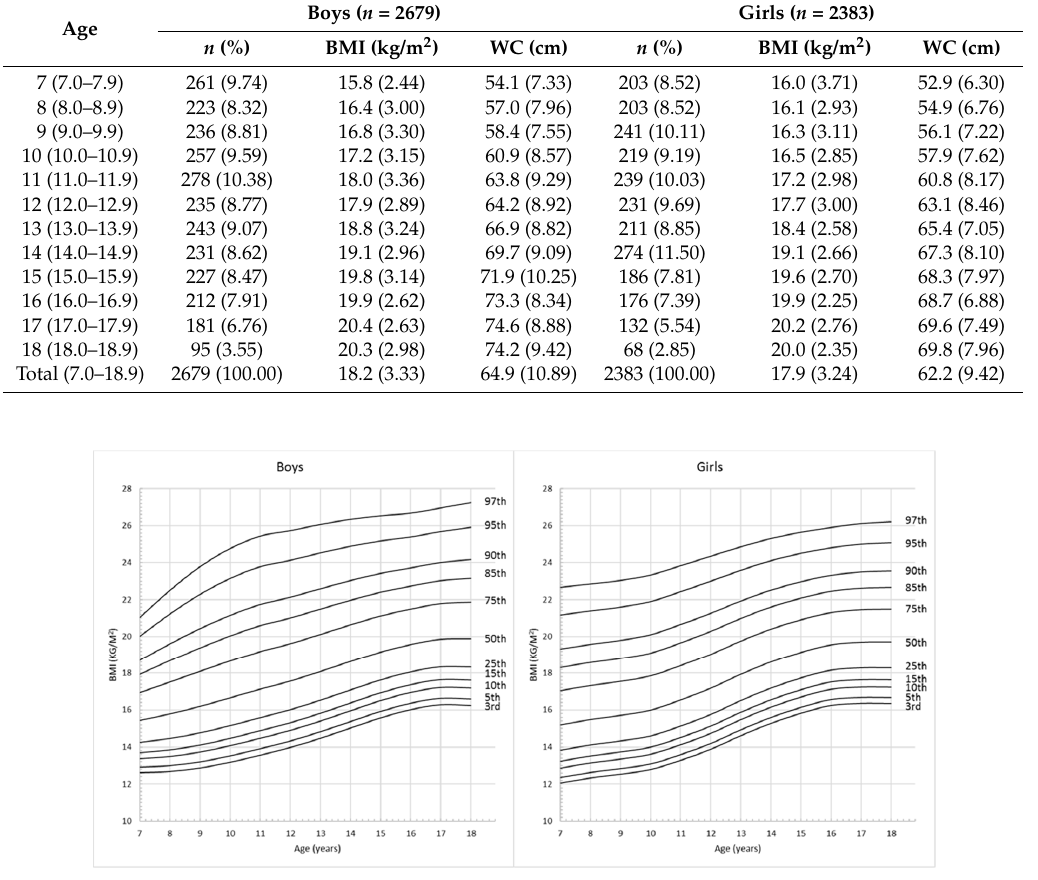
Figure 1. Gender- and age- specific BMI percentile curves for Chinese children and adolescents aged 7–18 years.